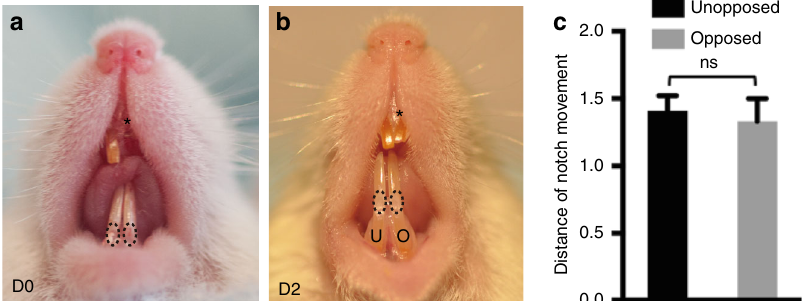
Fig. 7 Measurement of growth rates of opposed incisors after clipping. a , b Mice incisors were clipped on the upper right side and a marker notch made on both lower incisors just above the gingiva. The notch movements were measured 2 days after clipping. Asterisk indicates clipped incisor. c Quanti fi cation of notch movements shows no signi fi cant difference in growth rates of unopposed (U) and opposed (O) incisors. N > = 5 mice per group. NS not signi fi cant by Student ’ s t -test. Data presented as mean ±